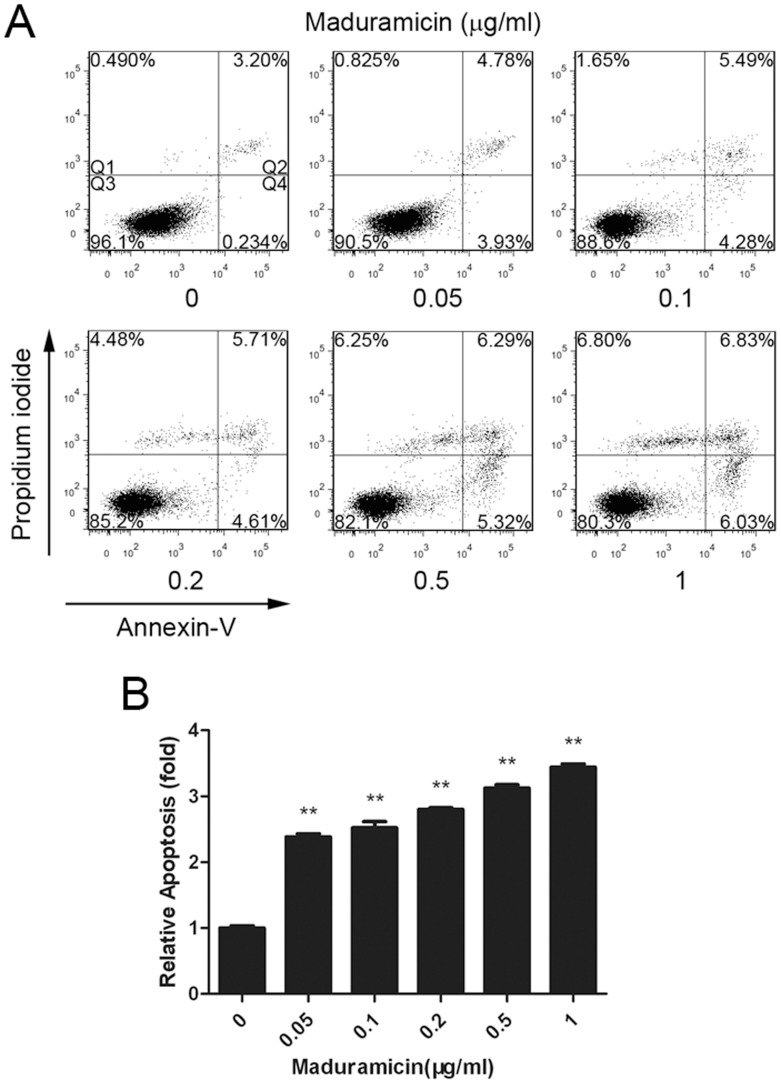
Maduramicin induces apoptosis in C2C12 cells.C2C12 cells were treated with maduramicin for 72 h at indicated concentrations, followed by Annexin V-PI staining and flow cytometry. (A) Histograms from a representative experiment show the apoptotic effect of maduramicin on C2C12 cells. The percentages of necrotic, late apoptotic, viable, and early apoptotic cells are displayed in Q1, Q2, Q3 and Q4, respectively. (B) Bar graphs show that maduramicin induced apoptosis of C2C12 cells in a concentration-dependent manner. Quantitative results (Q2+Q4) are displayed as fold change compared with control. Data represents mean ± SE (n = 3, corresponding to three independent experiments). **P<0.01, difference with the control group.